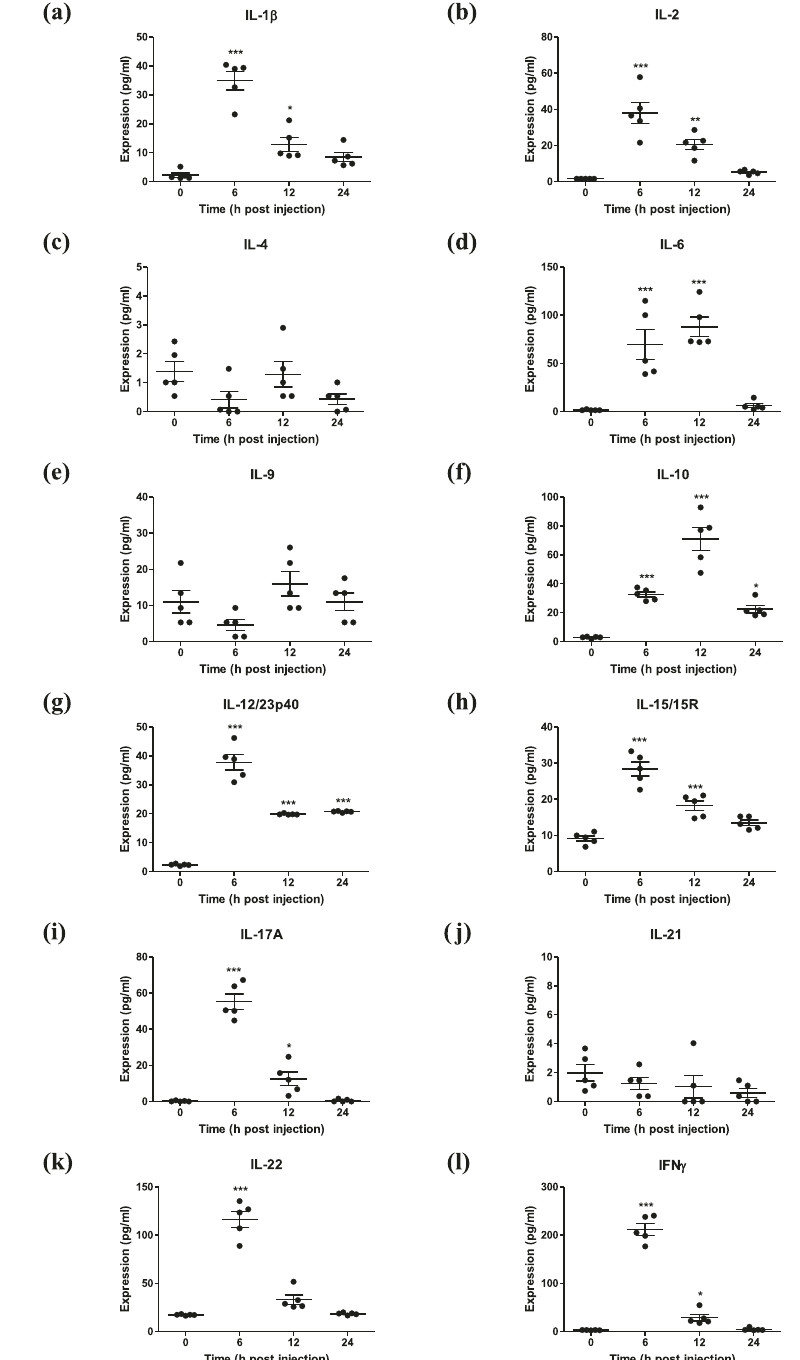
Fig. 2 rpHSP70-AD mediated cytokine expression and temporal kinetics in vivo. C57BL/6 mice ( n = 5/group/time point) were injected intraperitoneally with 50 μ g rpHSP70-AD and sacri fi ced at 0, 6, 12, and 24 h post-injection. Peritoneal lavage fl uid was collected by washing the peritoneal cavity with 2 mL chilled DPBS. Samples were then centrifuged, and the supernatant was analyzed for cytokines using ELISA. Cytokine pro fi les and temporal kinetics in vivo induced by rpHSP70-AD: IL-1 β ( a ); IL-2 ( b ); IL-4 ( c ); IL-6 ( d ); IL-9 ( e ); IL-10 ( f ); IL-12/23p40 ( g ); IL- 15/15 R ( h ); IL-17A ( i ); IL-21 ( j ); IL-22 ( k ); IFN γ ( l ). The data are represented as the mean ± SEM of triplicate measurements ( n = 5). Statistical analyses were performed using one-way ANOVA followed by Tukey ’ s post hoc test. * p < 0.05, *** p < Mice were vaccinated with a test vaccine and administered a and evaluate the ef fi cacy of the new recombinant rpHSP70-AD booster dose on 35 dpv. Blood was collected on 0, 7, 14, 28, 56, 84, adjuvant, especially as an immunostimulant, an oil emulsion-free and 168 dpv (Fig. 4a) and used for serological analysis, including rpHSP70-AD vaccine was prepared, and early, mid-term, and long- structural protein (SP) O ELISA (Fig. 4b), SP A ELISA (Fig. 4d), and term immunity and memory responses were observed in mice virus-neutralizing (VN) titers (Fig. 4c, e). Mice were challenged with (Fig. 4a – m).